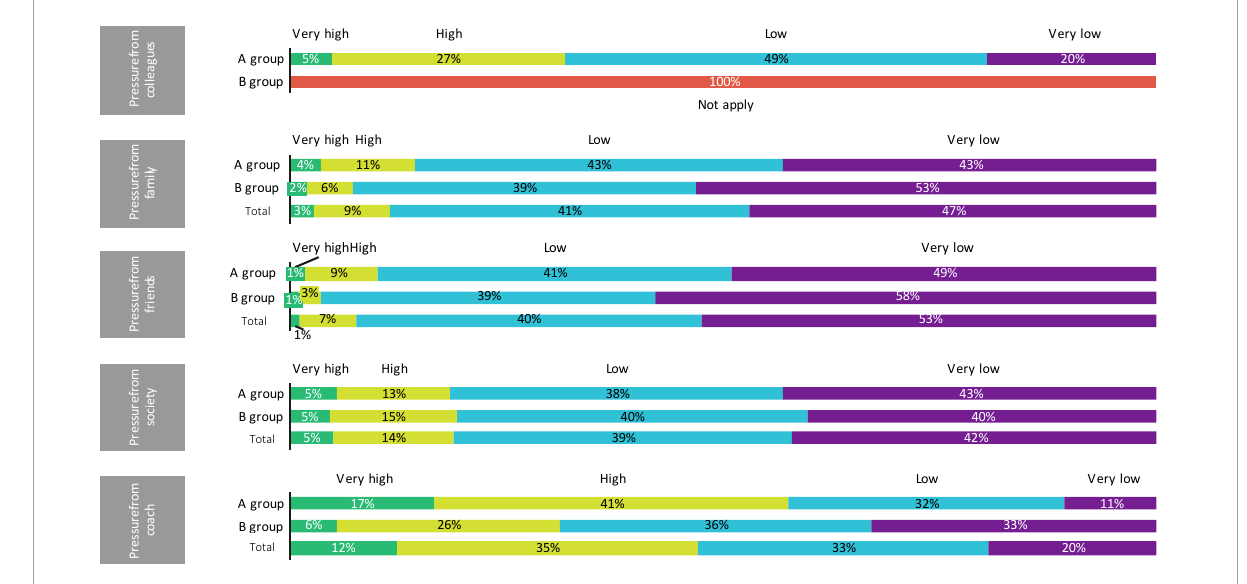
FIGURE3 Distribution of the sample according to the pressure perceived from colleagues, family, friends, society, and coach.